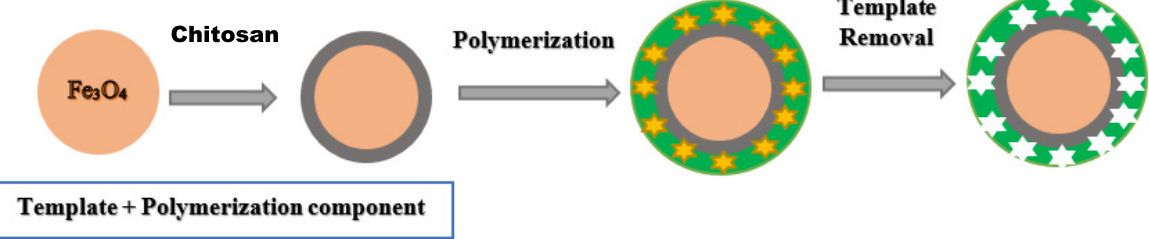
Figure 3. The preparation of MMIPs using chitosan.